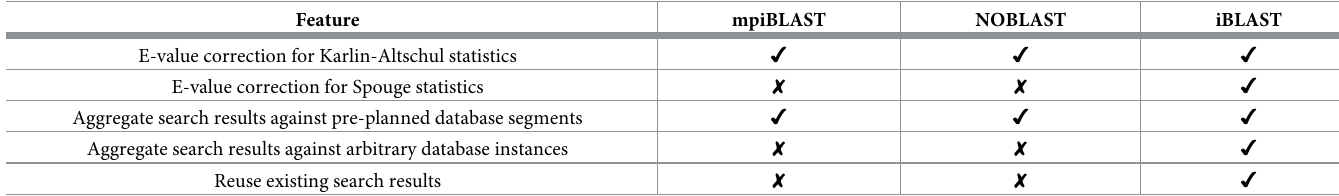
Table 1. Comparison of three different BLAST tools that explicitly deal with e-value statistics correction. iBLAST supports e-value correction across time and space without requiring prior knowledge of the entire database while the other tools can perform e-value correction in limited